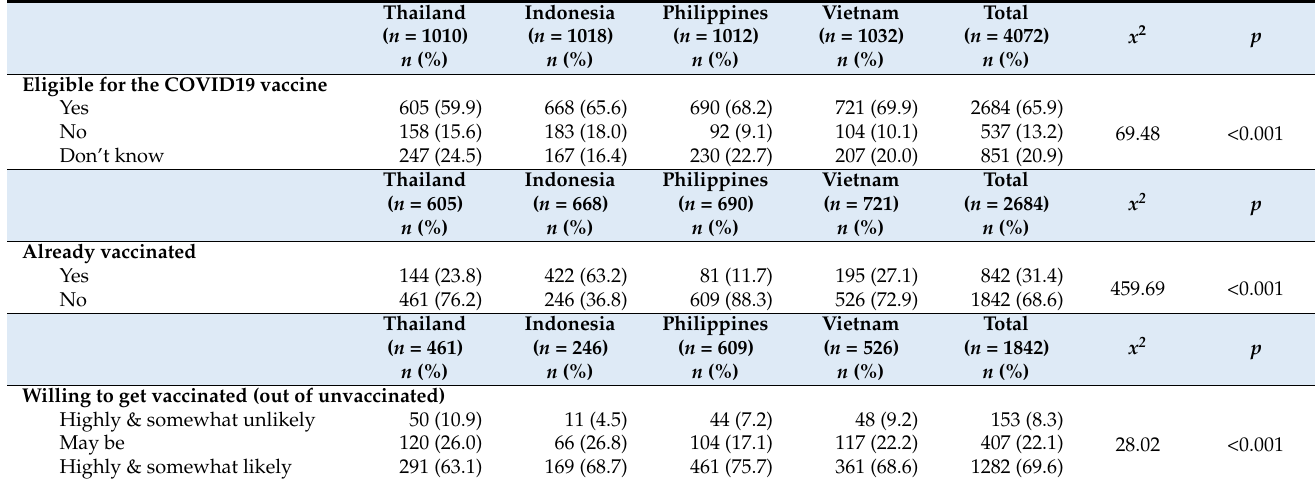
Table 5. COVID-19 Vaccination